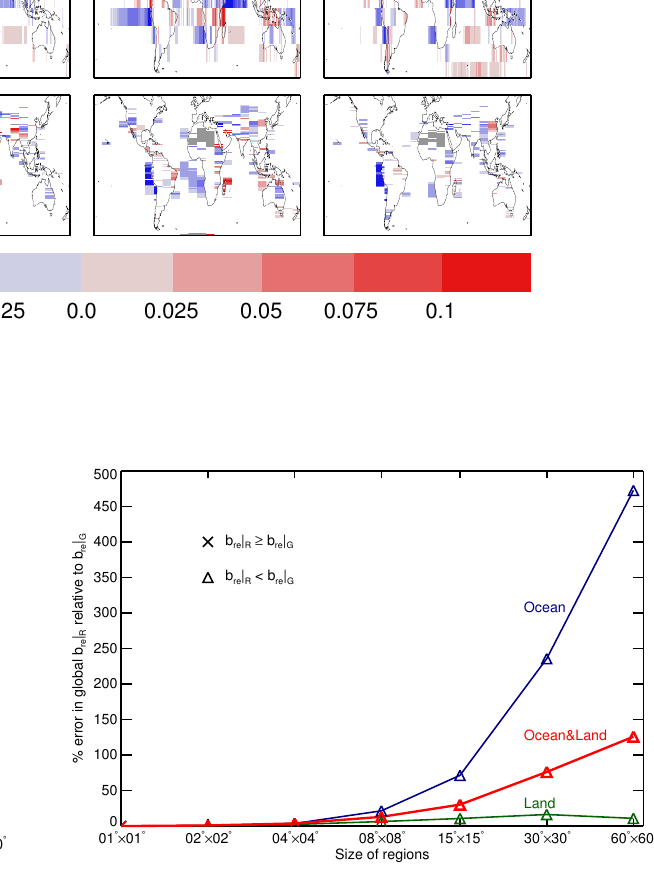
Fig. 6. Absolute percentage error in the globally-averaged sensi- tivity of N e to τ a due to the region-method compared to the grid- method. The green data line is for land-only, the blue is for ocean- only and the red is for ocean and land combined. Crosses show where the region-method leads to an overestimate of the sensitiv- ity (i.e. the error is positive), and triangles where the sensitivity is underestimated (the error is negative). As elsewhere in this study, weighting has been applied using the one-sigma error in the sensi- tivities. Latitudinal area weighting has not been applied.